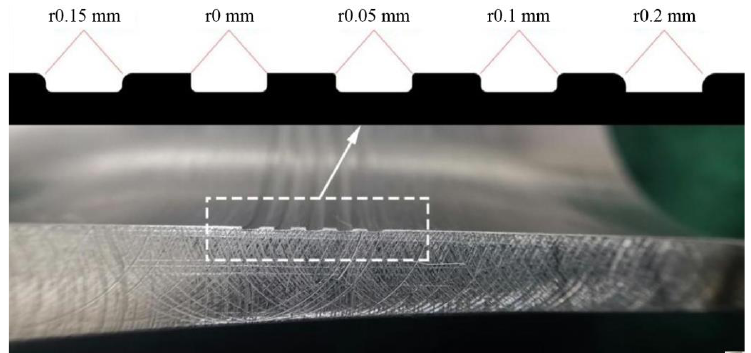
Figure 4. Schematic of the dimensions of the variable fillet radius pipe sleeve.